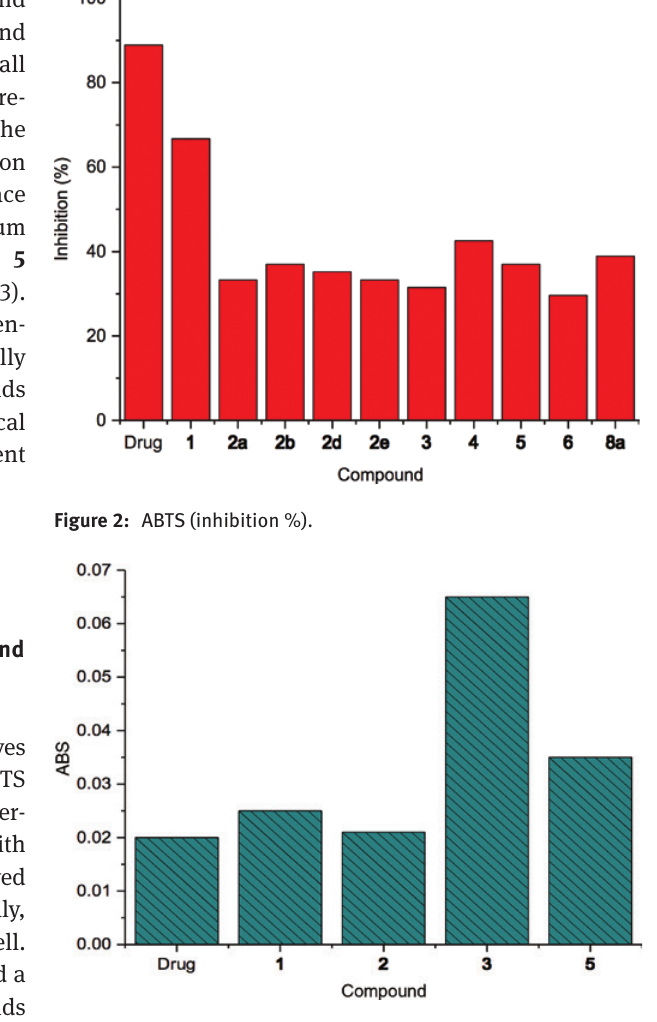
Figure 3: Bleomycin-dependent DNA damage.